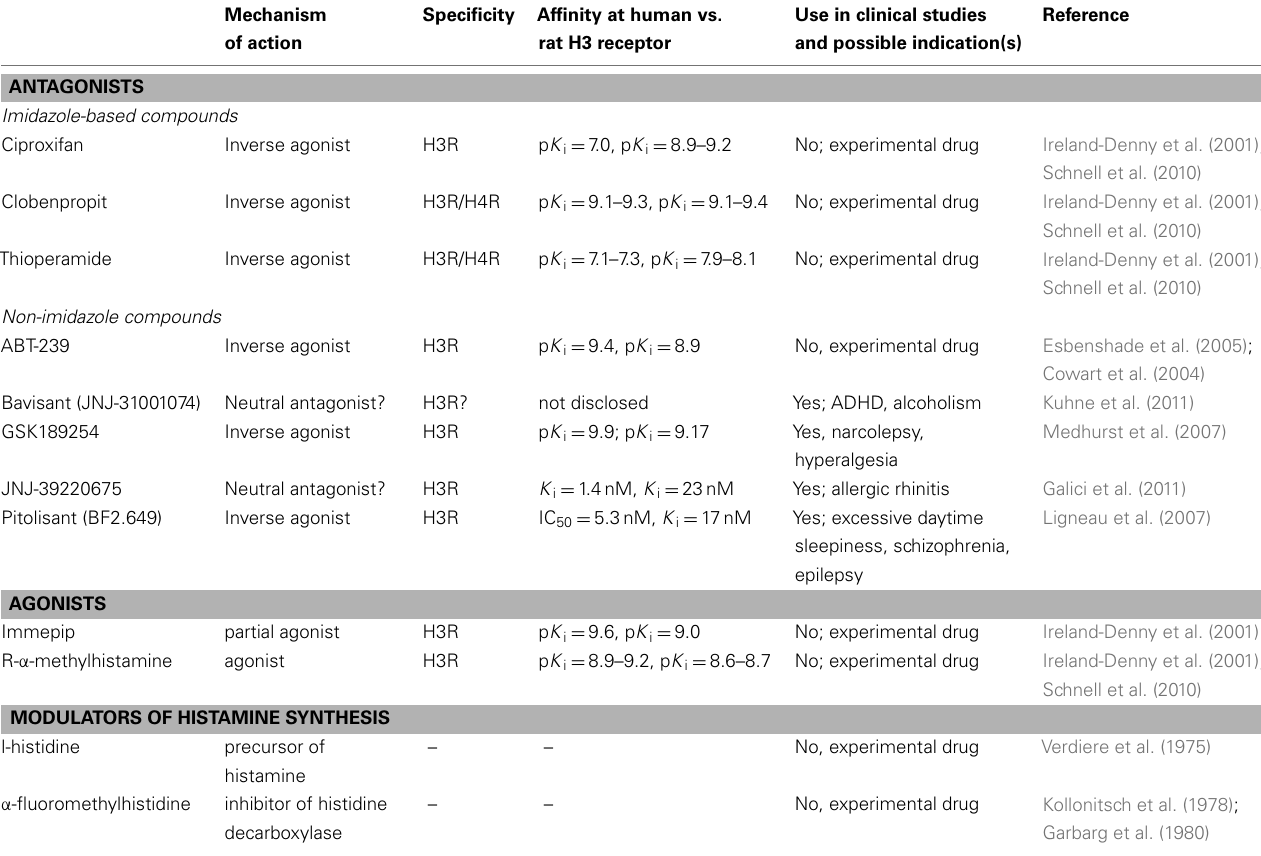
Table 2 | Examples of drugs used in histamine research and in clinical